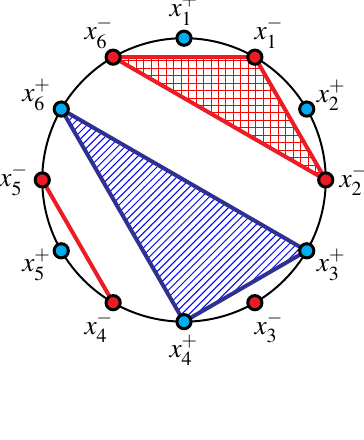
Figure 4: A MNP of order